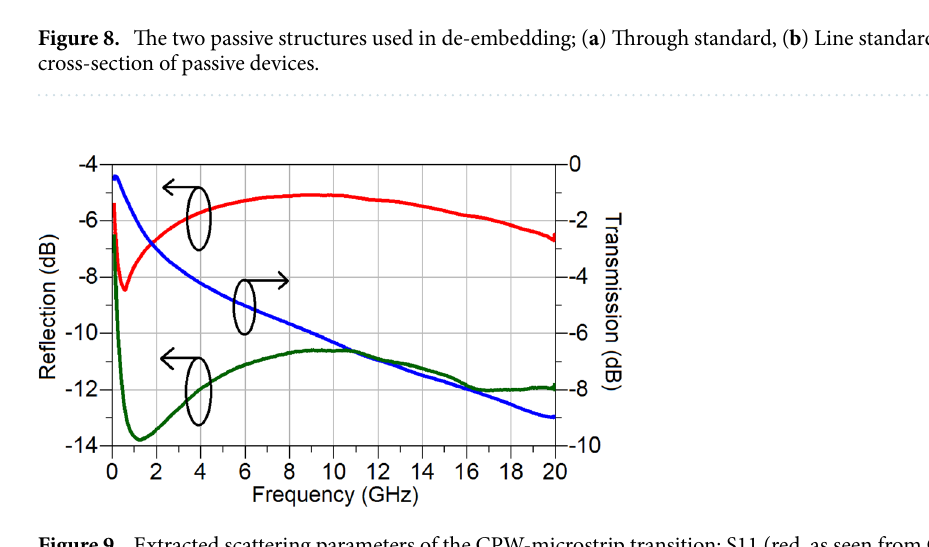
Figure 9. Extracted scattering parameters of the CPW-microstrip transition; S11 (red, as seen from CPW side), S22 (green, as seen from microstrip line side) and S21